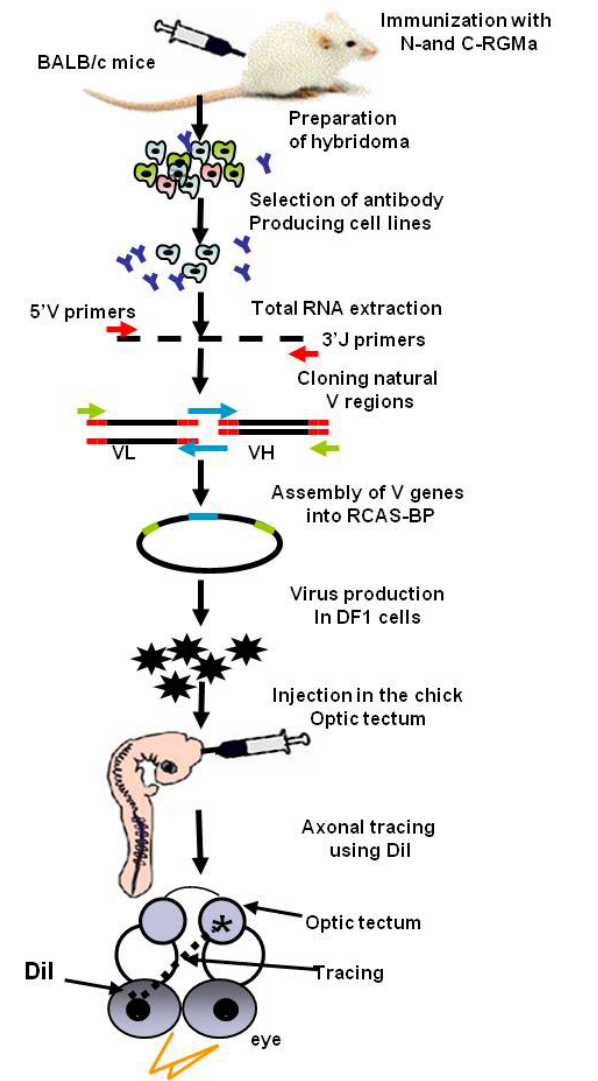
neurodegenerative diseases where the target is in the brain. For instance, as a potential therapy in Alzheimer’s disease, peripherally administered scFv-TIR conjugates reduced the level of amyloid plaques in the brain of mouse models, and antibodies were detected in the brain [46–49]. Figure 2. Schematic representation of the process by which scFvs are generated from hybridoma cells and injected in the developing chick brain. Mice were immunized with [3] antigens from the N- and C-terminal parts of repulsive guidance molecule (RGMa) and antibodies generated. The V and V regions were amplified from the hybridoma mRNA, H L linked and cloned in the replication-competent retroviral vector (RCASBPB) vector. Virus was produced in DF1 cells and injected in the optic tectum of the chick embryo at E2 (Embryonic day 2). A DiI dye was implanted at E15 in the eye to trace the fibers targeting the tectum. Embryos were sacrificed two days later, and tracing revealed that retinal fibers displayed targeting errors in the tectum, due to neutralization of the RGMa domains